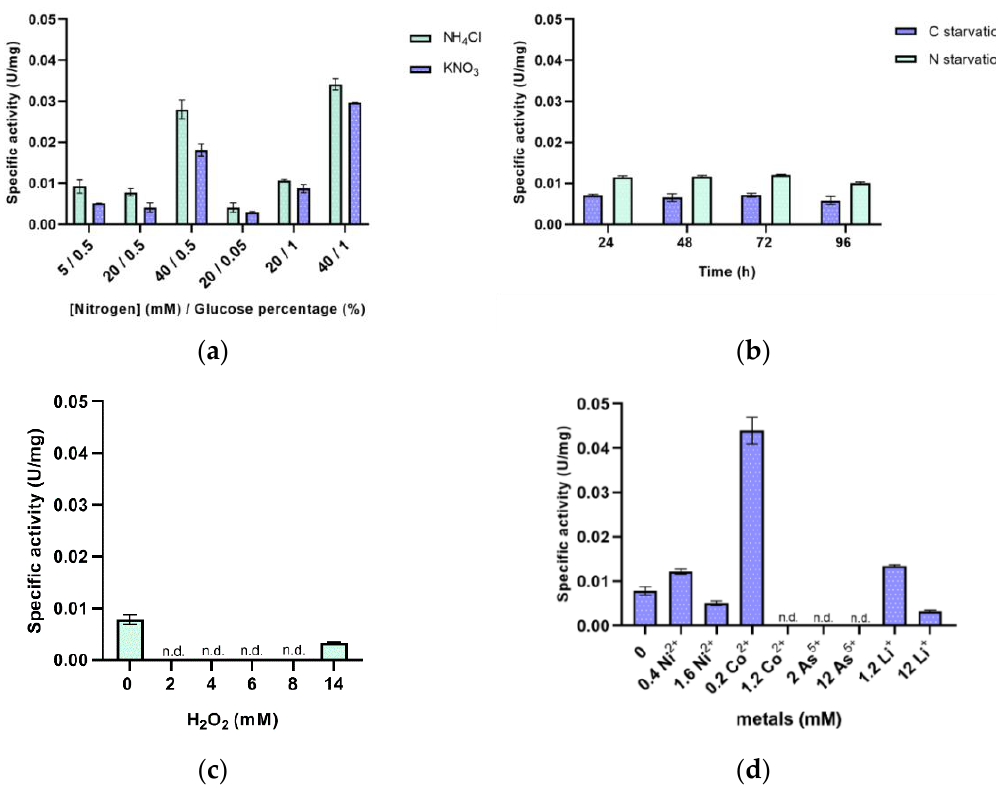
Figure 5. Possible elements of the promoter region. In green the TATA-box; in pink, the BRE-element; in blue, the -11/-10 motif; in yellow, the transcriptional start site; and in bold, the ATG of the lrp gene.